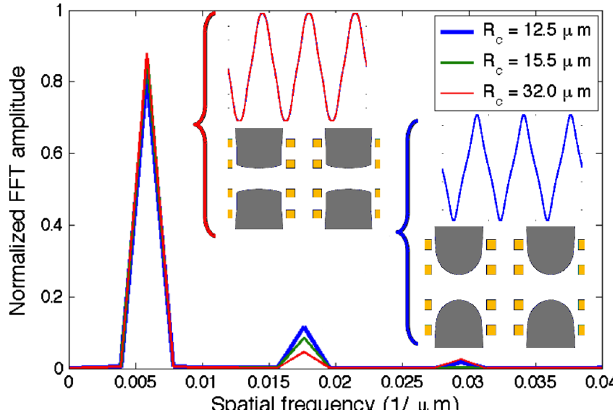
FIG. 8. Plot of the spatial harmonics of the undulator field in ¼ 100 (cid:1) m and g ¼ 12 : 5 (cid:1) m for several pole Design 2 with (cid:2) u tip curvature radii. Data was taken from 2D magnetostatic FEM